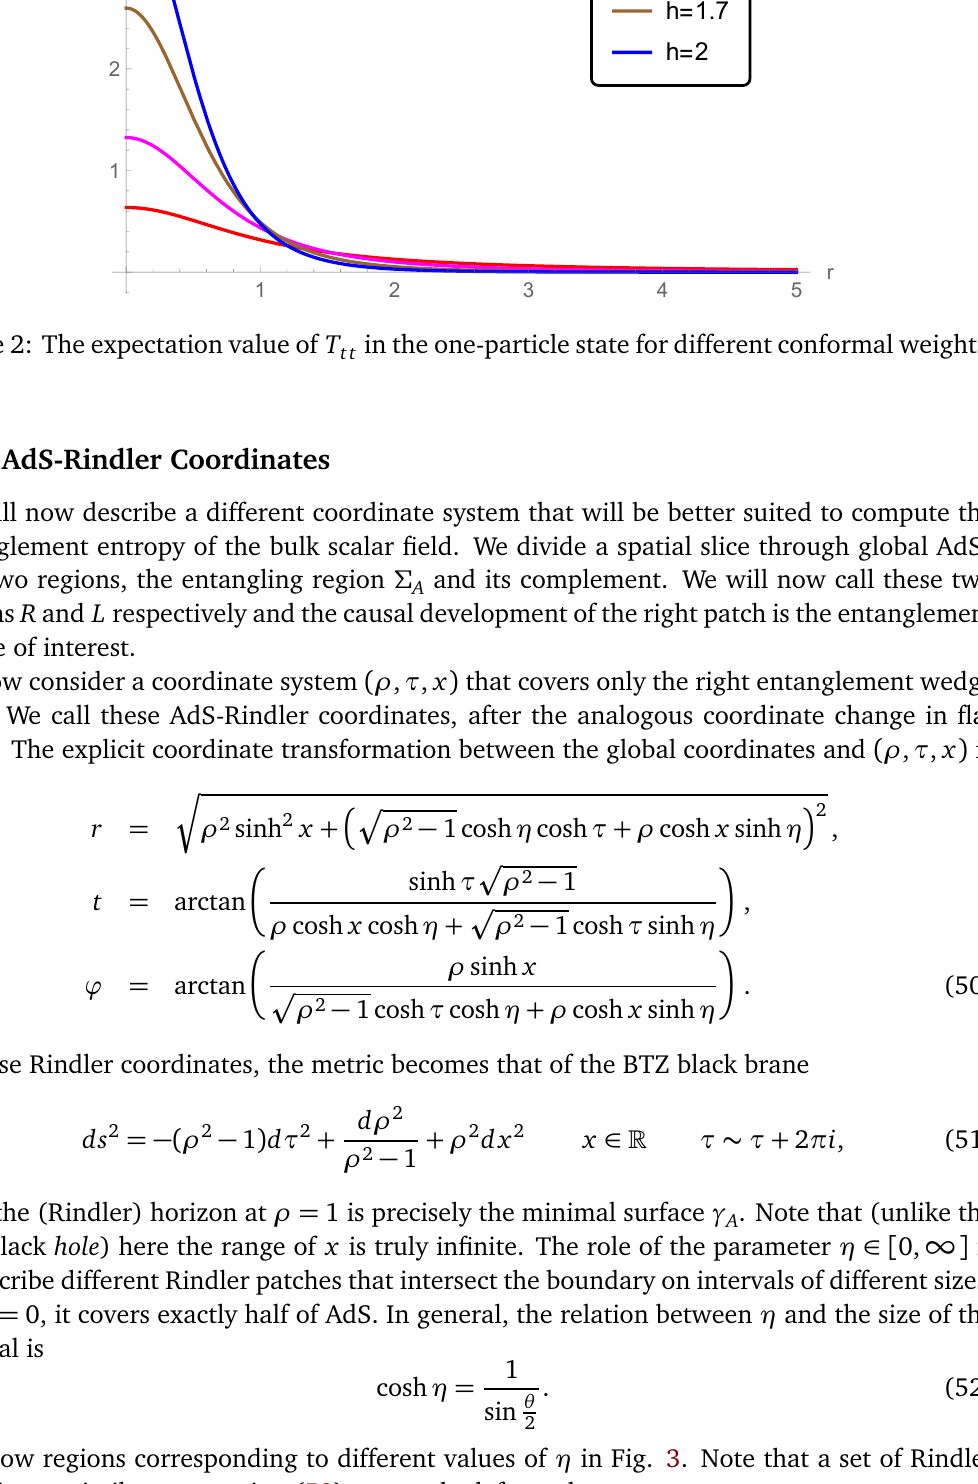
Figure 2: The expectation value of T